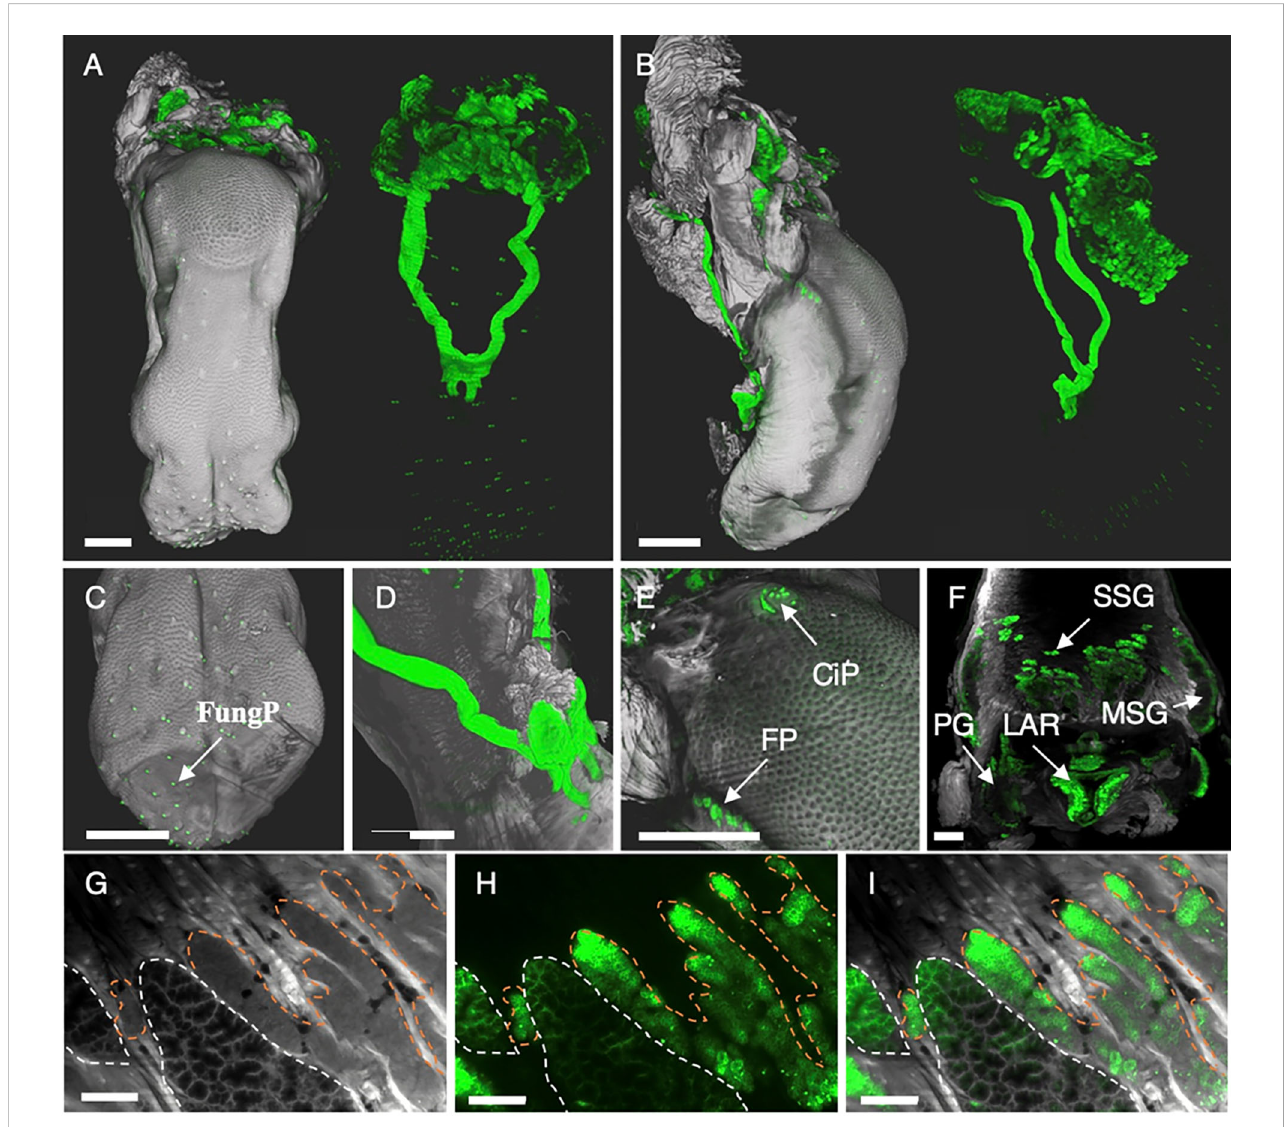
FIGURE 6 3D renderings and single LSFM images display highly heterogeneous binding of anti-EpCAM antibody G8.8R to the tongue and salivary glands. (A) Dorsal and (B) lateral view of surface renderings of the tongue and associated tissues. Left images depict renderings of the tissue anatomy (grey) and the bound anti-EpCAM antibody (G8.8R in green) as overlay. Right images depict only the antibody signal (green) without anatomical context. (C) Tip of the tongue with positive gustatory fungiform papillae (FungP). (D) Positive sublingual excretory ducts at the tongue bottom. (E) Circumvallate papilla (CiP) and folate papillae (FP). (F) Mucous salivary glands (MSG) and serous salivary glands (SSG), parotid gland (PG) and larynx (LAR). (G) Single digital section of the tongue depicting both mucous (white dashed lines) and serous (orange dashed lines) salivary gland anatomy, (H) bound G8.8R (green) and (I) overlay of both channels. Scale bars = 1 mm (A – F) and 150 m m (G – I)